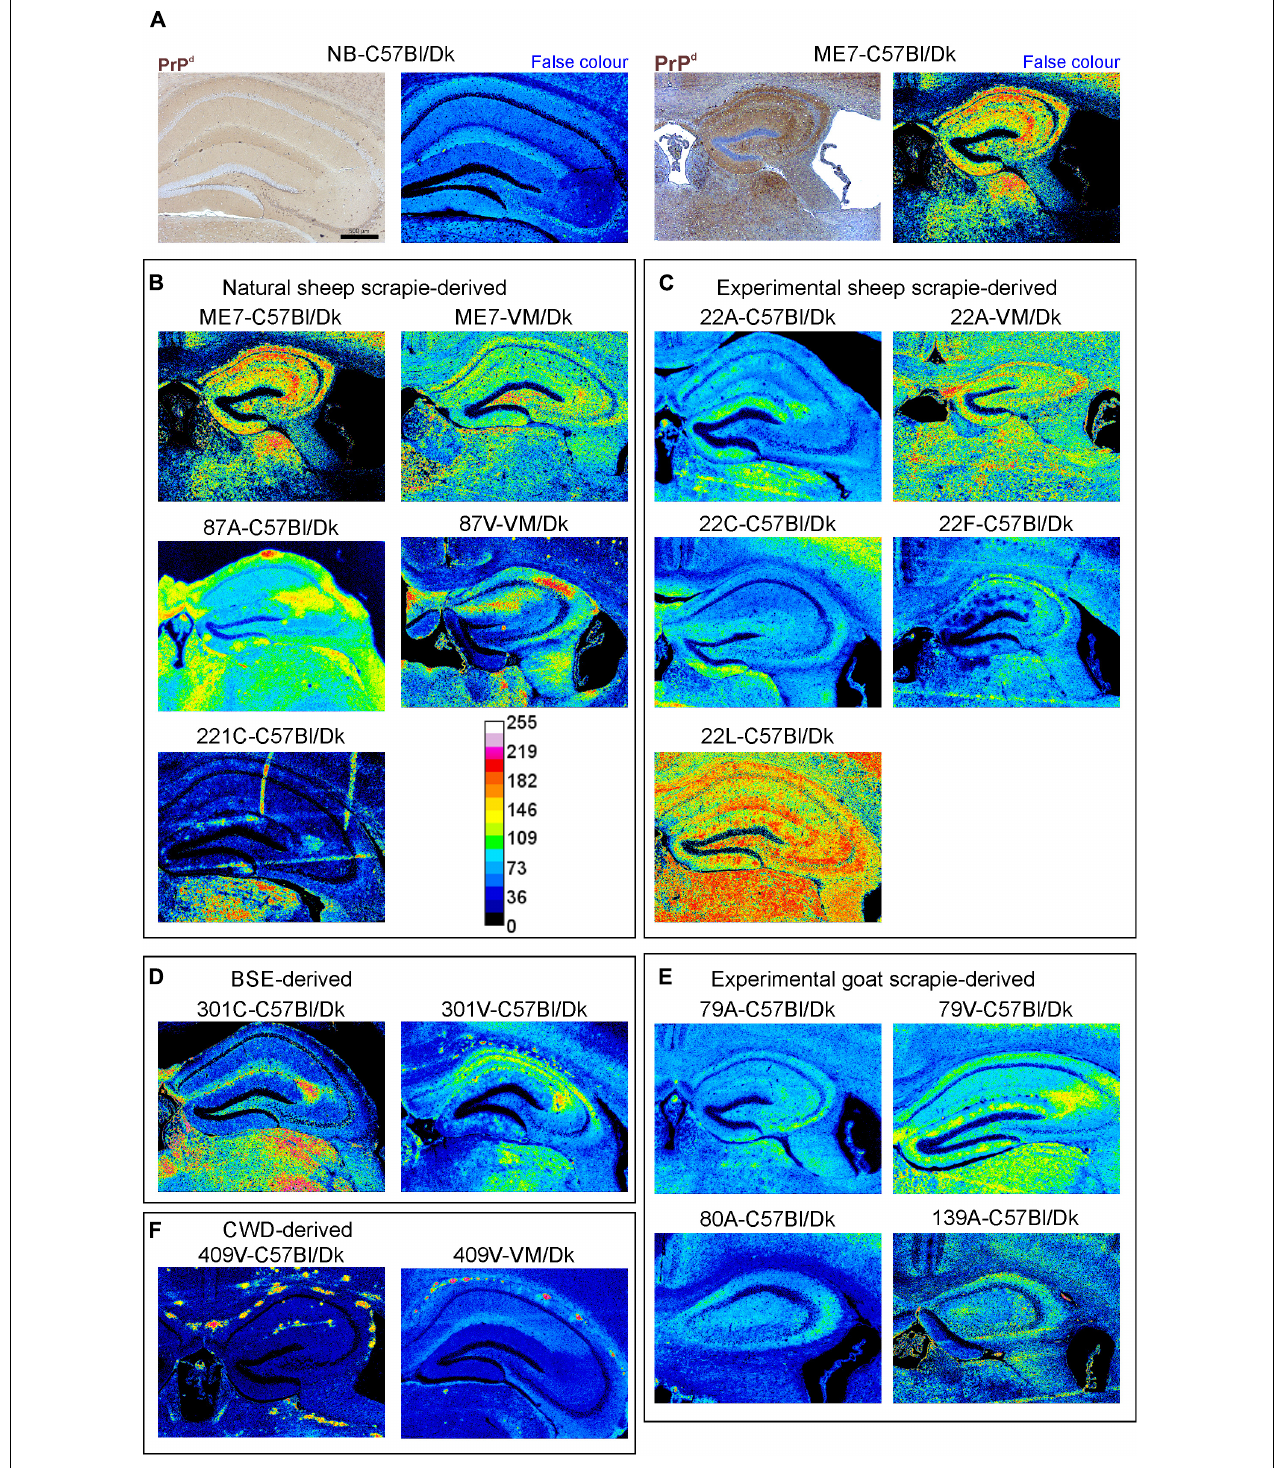
FIGURE 3 | Immunohistopathological comparison of the PrP d immunostaining in the brains of mice infected with a variety of distinct prion agent strains. Groups of C57Bl/Dk or VM/Dk mice were injected intracerebrally with a variety of distinct prion agent strains ( Table 1 ). Brains were collected at the terminal stage of disease and immunostained to detect PrP d . Images were then false-colored to compare the signal intensities of the immunostaining between each group. (A) Normal brain infected mice display no PrP d compared to mice terminally affected with ME7 scrapie prions. (B–F) Comparison of false colored images to show the variation in PrP d + immunostaining between diverse prion strains isolated from a variety of sources. Representative images from 6 mice/group are shown. Scale bars = 500 µ m.